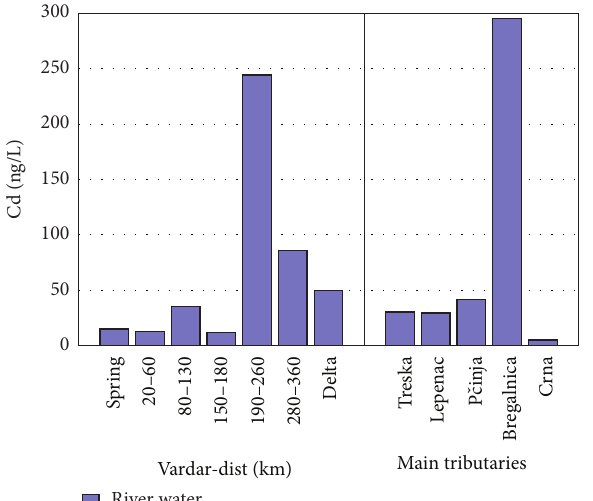
Figure 11: Factor 4 (factor scores) of river Vardar and main